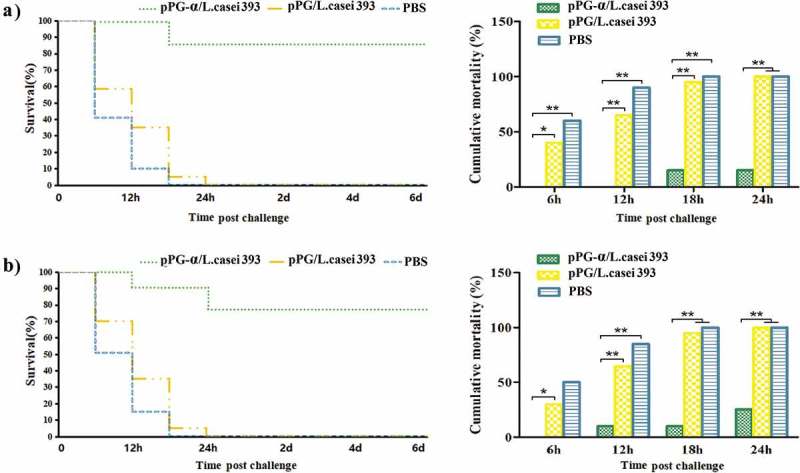
Neutralizing abilities of antibodies induced in immunized mice against C. perfringens natural α-toxin. C. perfringens natural α-toxin was treated with the serum IgG and mucosal sIgA antibodies obtained from the immunized mice in each group, followed by a challenge to the mice to evaluate the neutralizing abilities of the antibodies. A high survival rate was registered among the mice challenged with the α-toxin treated with IgG (a) or sIgA antibodies (b) induced by pPG-α/L. casei 393, whereas mice challenged with the α-toxin treated with antibodies obtained from mice immunized with pPG/L. casei 393 and PBS all died.